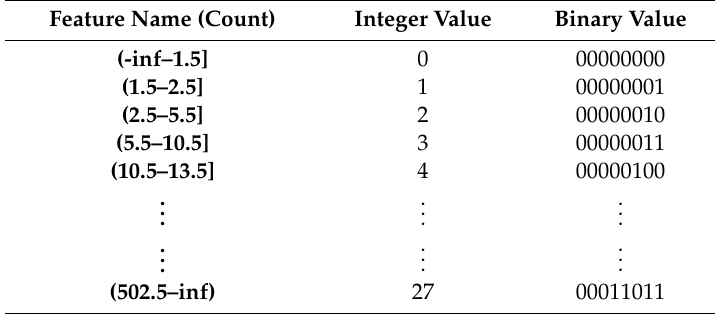
Table 2. Bins assigned integer values and then converted into the binary